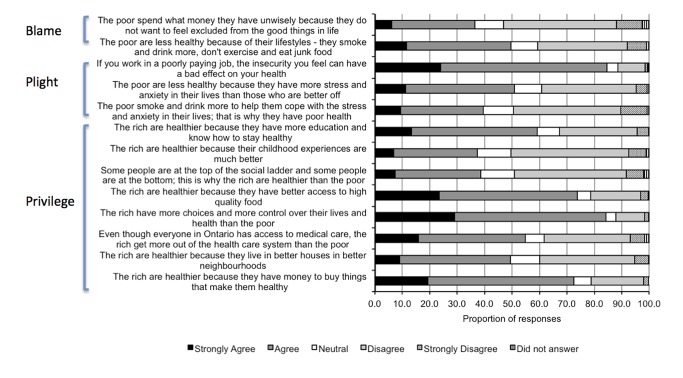
Distribution of responses.